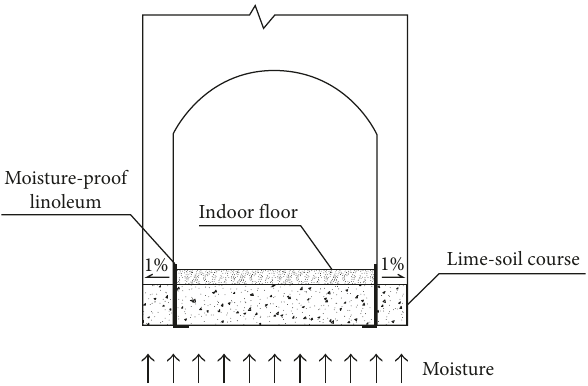
Figure 3: Damp-proof course at the bottom of the cave dwelling.